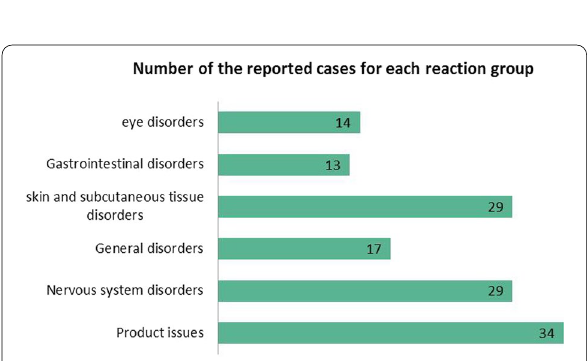
Fig. 2 Number of the reported cases of each reaction